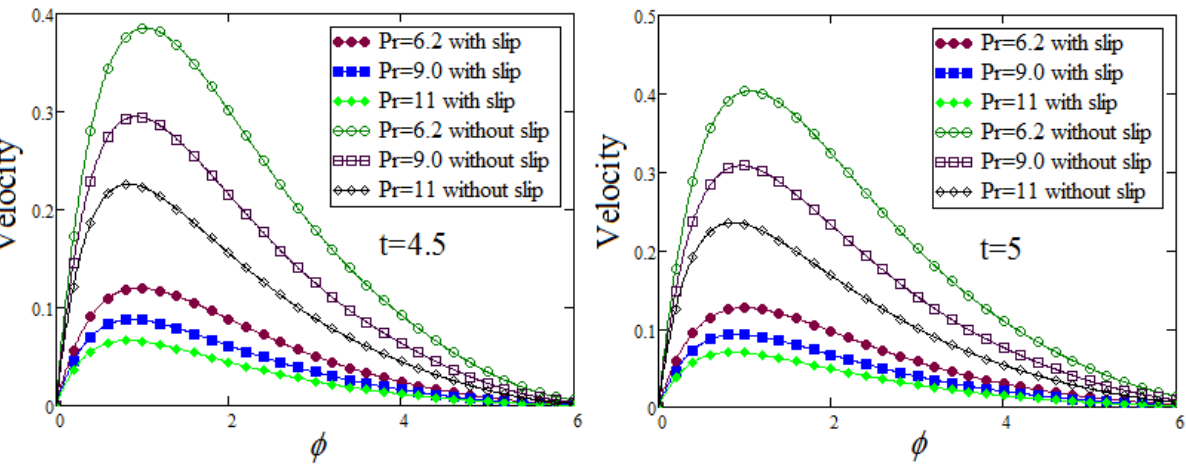
Figure 13. Graphical representations of velocity profile in the presence of slip and no slip conditions by taking the dissimilar values of Pr at two different levels of time, when Gr = 5, Gm = 3.5, ℘ = 0.4, ω = 0.5, Sc = 9, α = 0.5 β = 0.3, and γ = 0.4.